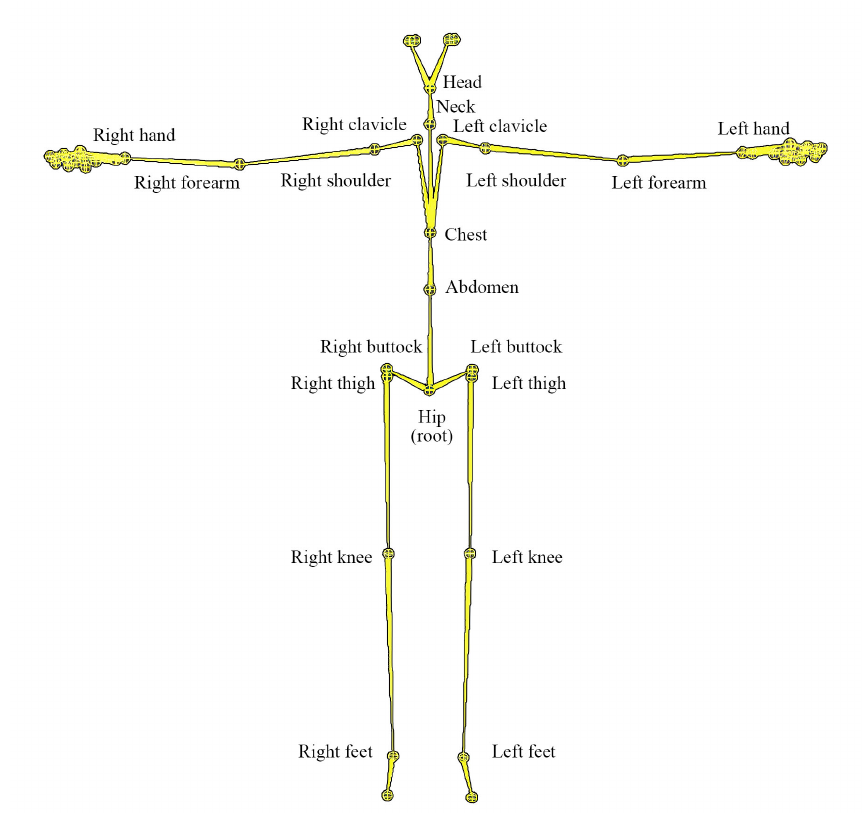
Figure 2. The skeleton hierarchy of CMU motion capture